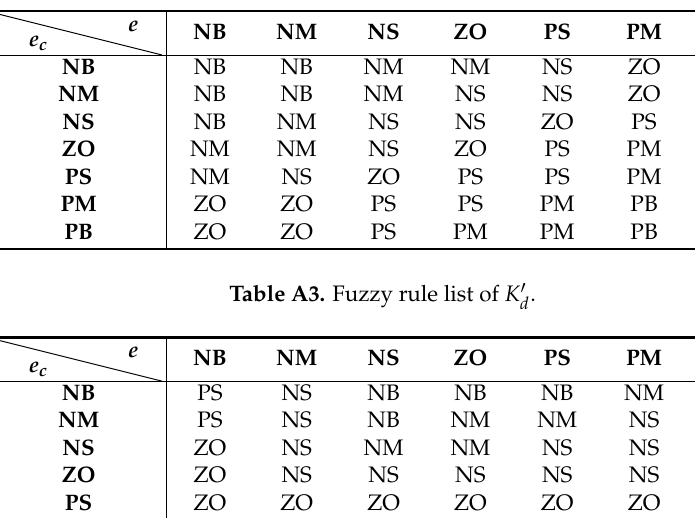
Table A2. Fuzzy rule list of K (cid:48)